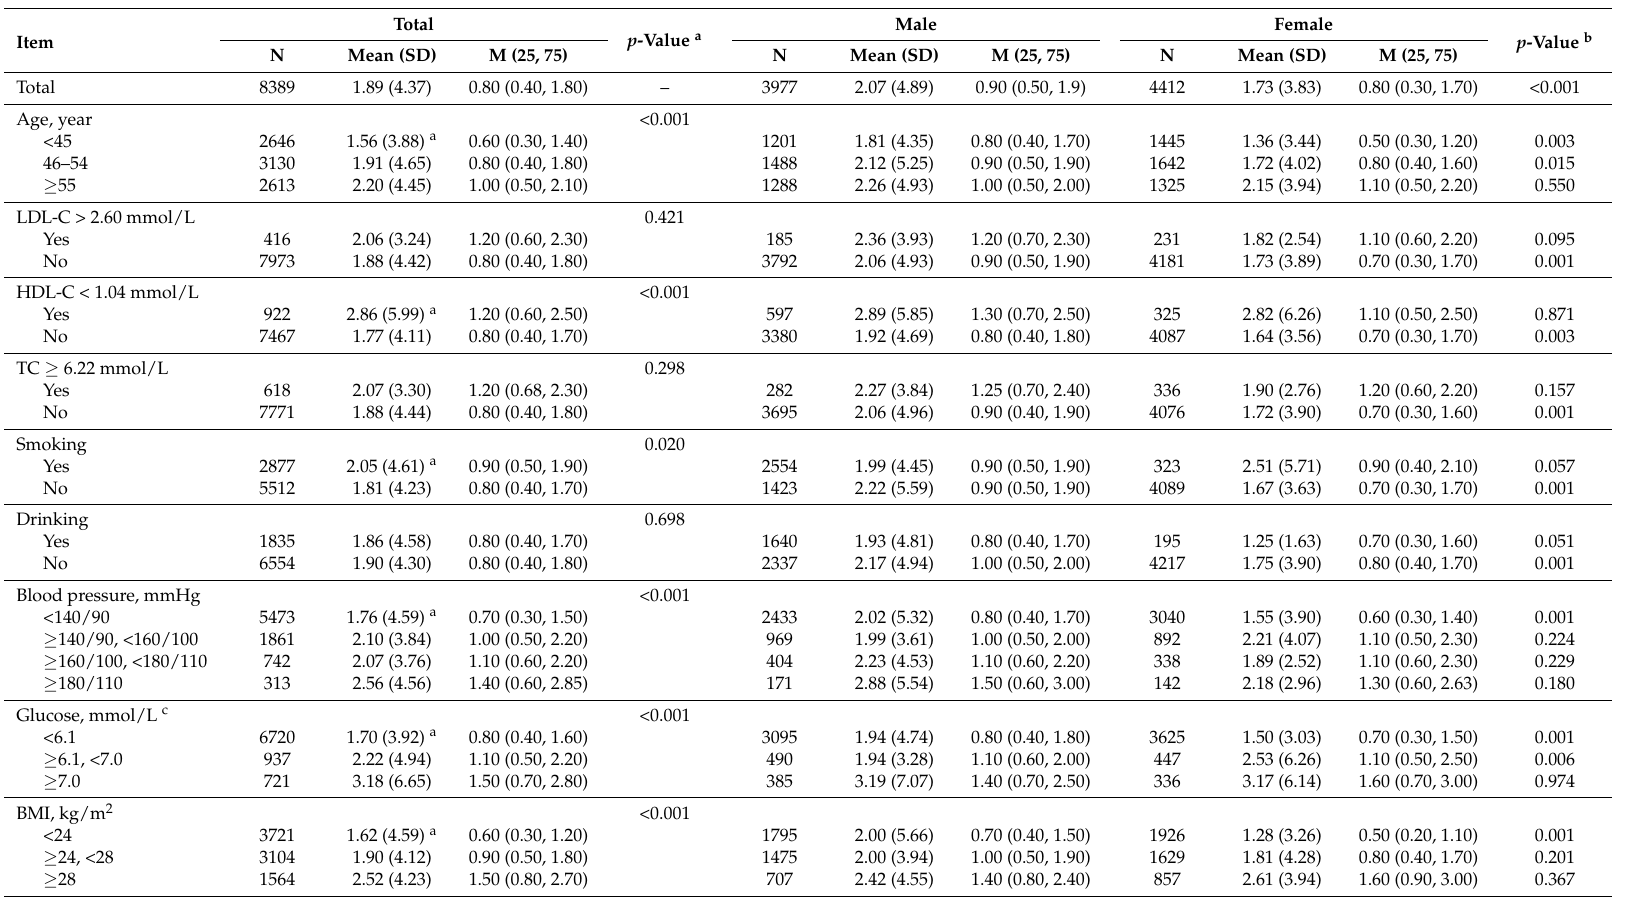
Table 2. Distribution of hs-CRP by individual risk